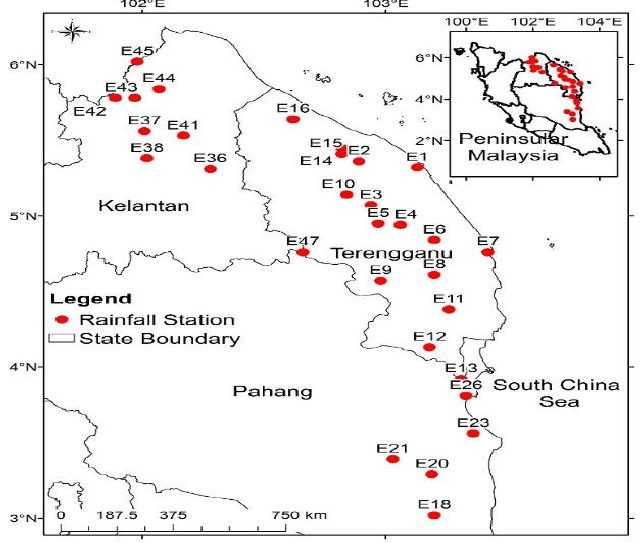
Figure 1. The locations of the observed 30 rainfall stations on the east coast of Peninsular Malaysia.